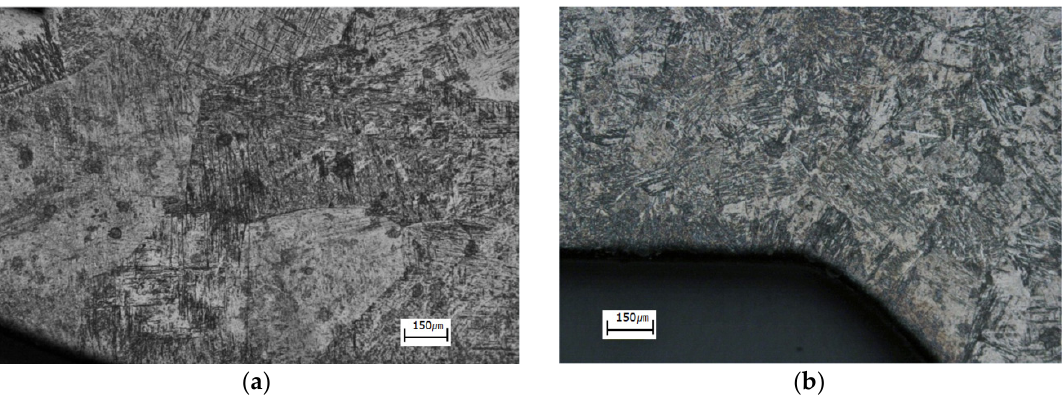
Figure 10. Optical image of Ti ‐ 3Al ‐ 2.5V pipe weldment: ( a ) weld metal; ( b ) heat affected zone. Metals 2016 , 6 , 243